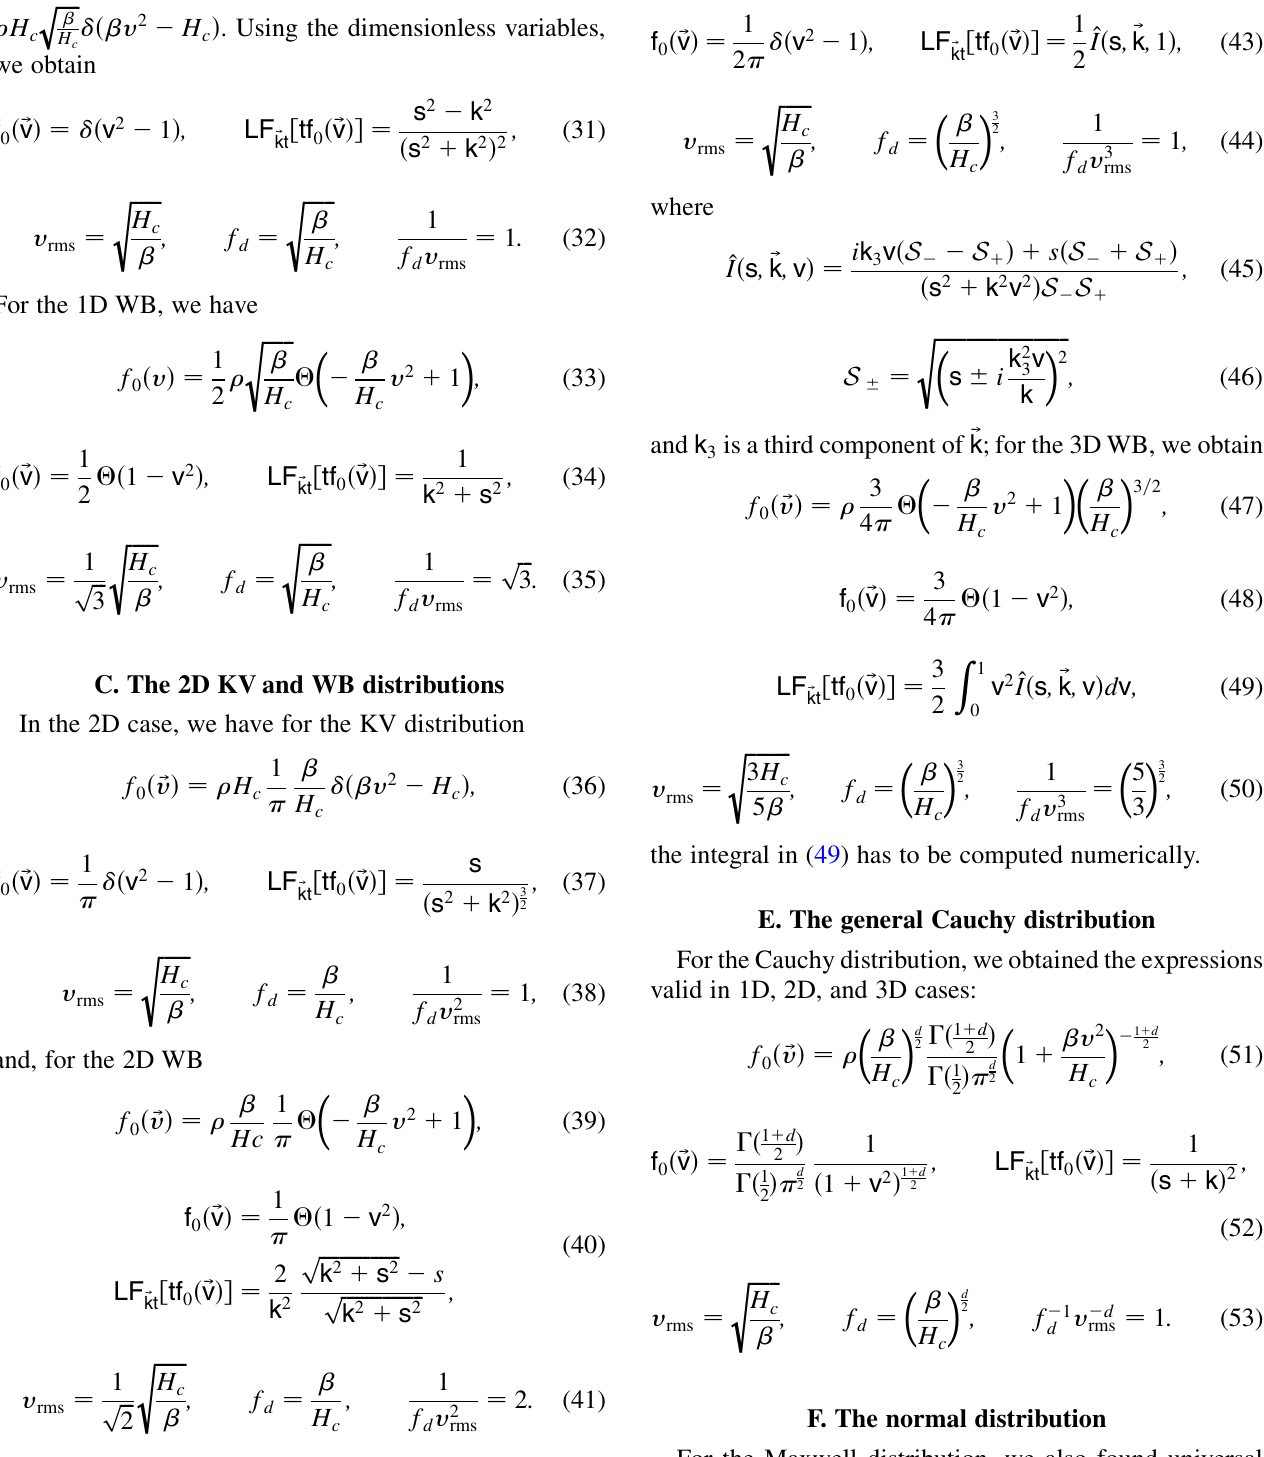
ffiffiffiffiffiffiffiffiffiffiffiffiffiffiffiffi p k 2 þ s 2